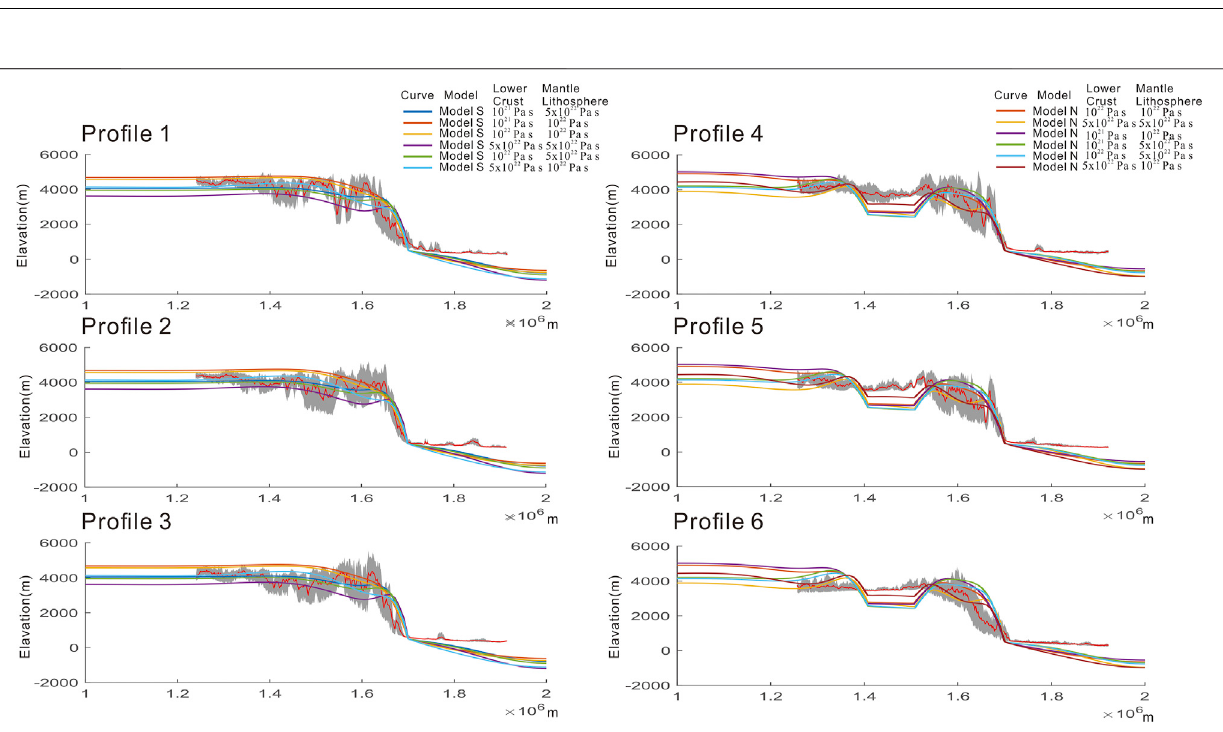
FIGURE 5 | Comparison between the simulation results and extracted DEM results. Pro fi les 1, 2, and 3 are the results of Model S merged with the extracted DEM pro fi les 1-1 ′ , 2-2 ′ , and 3-3 ′ , respectively. Pro fi les 4, 5, and 6 are the results of Model N merged with the extracted DEM pro fi les 4-4 ′ , 5-5 ′ , and 6-6 ′ , respectively. In the legend exhibits different the viscosity of lower crust and mantle lithosphere in the Tibet